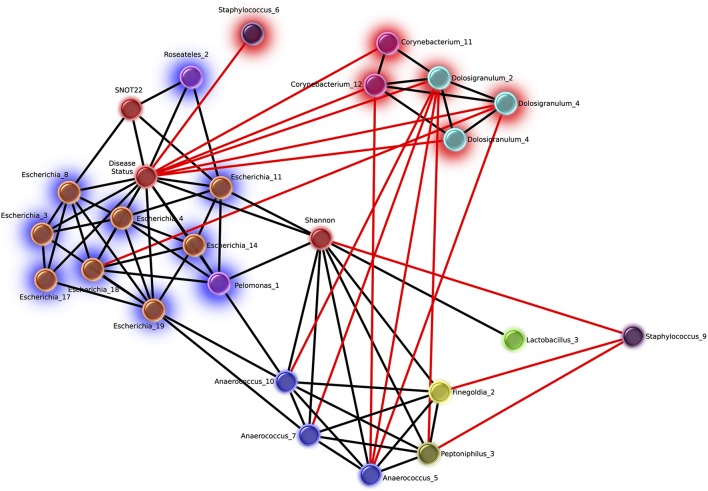
Network of OTUs associated with disease status, and strong significant correlations to other OTUs. Networks were calculated using extended local similarity analysis and plotted using the Cytoscape3 software package. Nodes are colored by genus taxonomic assignment, and metadata category nodes are colored red. Glow behind nodes indicates the relationship to disease status (blue, positive correlation; red, negative). Black lines indicate positive correlations, and the length indicates the strength (short, strong; long, weak). Red lines indicate negative correlations and the length indicates the strength in the opposite direction to black (long, strong; short, weak).